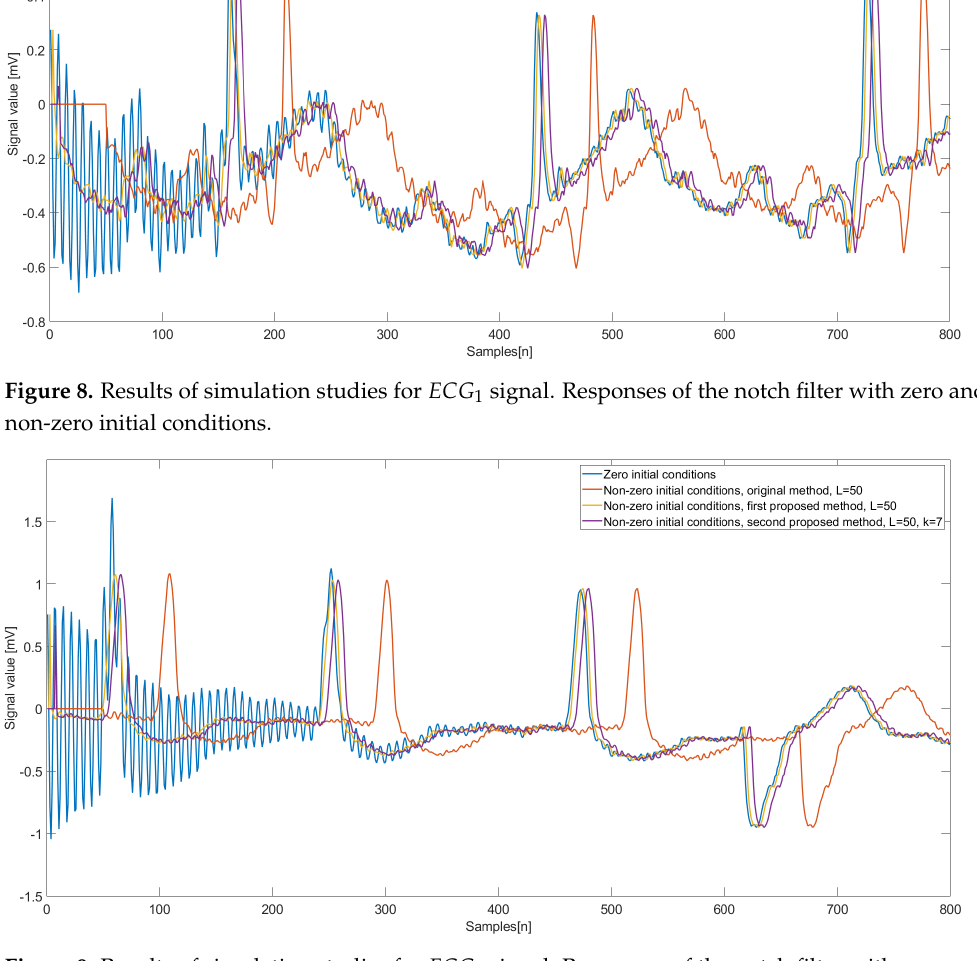
Figure 9. Results of simulation studies for ECG 2 signal. Responses of the notch filter with zero and non-zero initial